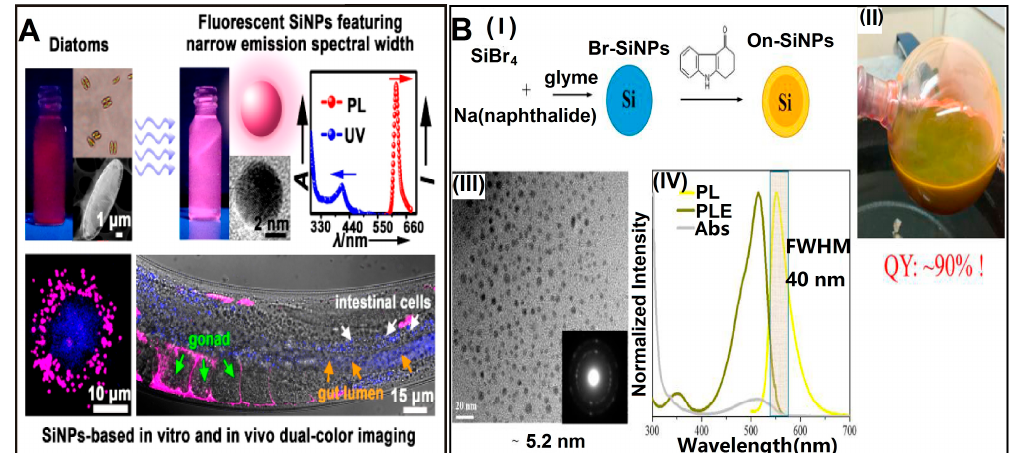
Figure 2. ( A ) Schematic illustration of biomimetic synthesis of fluorescent SiNPs and their use for in vitro and in vivo dual-color imaging. Reproduced with permission from ref. [38]. Copyright 2015, American Chemical Society; ( B ) schematic illustration of synthesis of yellow-emitting SiNPs with ultrahigh quantum yield and narrow photoluminescence (PL) bandwidth; ( I ) scheme of synthetic and modified procedures; ( II ) photograph of SiNPs in glyme under ambient light; ( III ) TEM image of SiNPs. Inset is the selected-area electron diffraction pattern of SiNPs; IV) PL, photoluminescence excitation (PLE), and absorbance (Abs) spectra of SiNPs. Reproduced with permission from [44]. Copyright 2016, American Chemical Society.